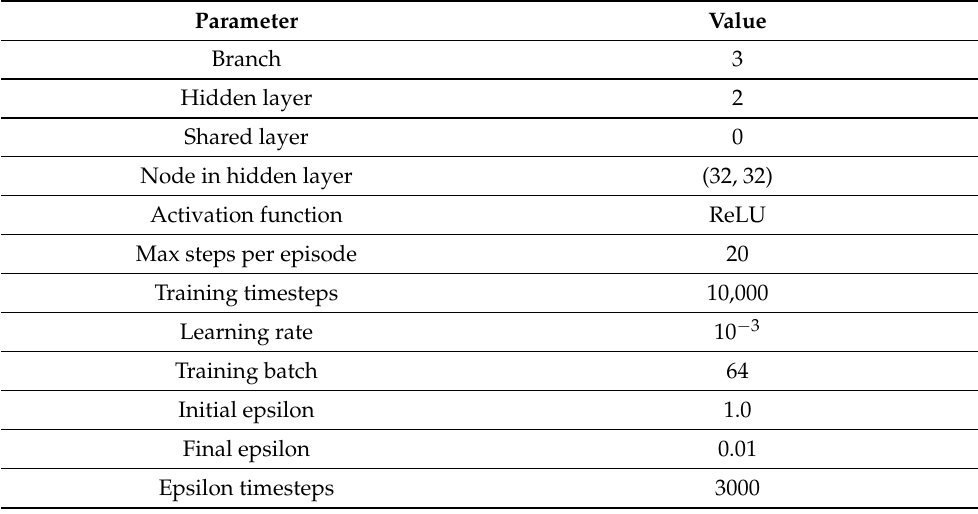
Table A1. The parameters of the RL agent for antenna tilt use case.